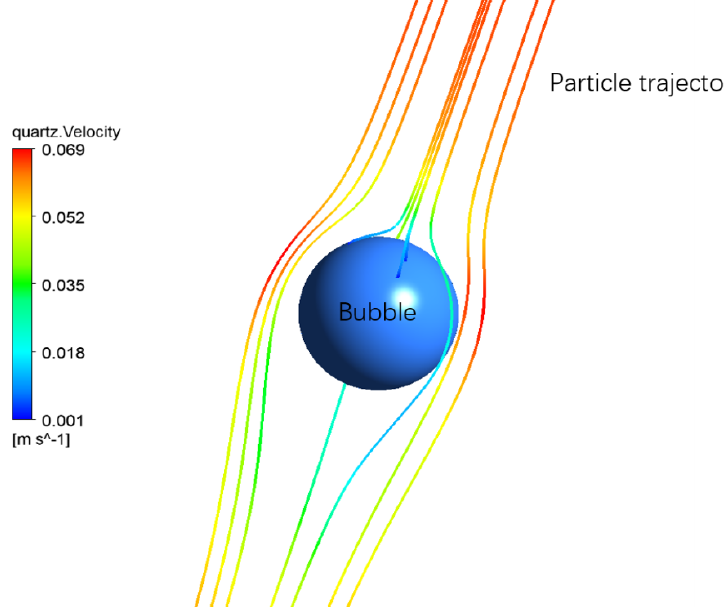
Figure 2. 3D schematic of typical particle paths around a bubble caused by relative motion between the bubble and surrounding slurry. The tendency of particles to follow streamlines, as illustrated, reduces the collision frequency below the straight path interception frequency (Li 2019) [3]. Table 2. The mesh numbers, particle numbers, fluid velocities, and Reynolds number corresponding to the bubble diameter.